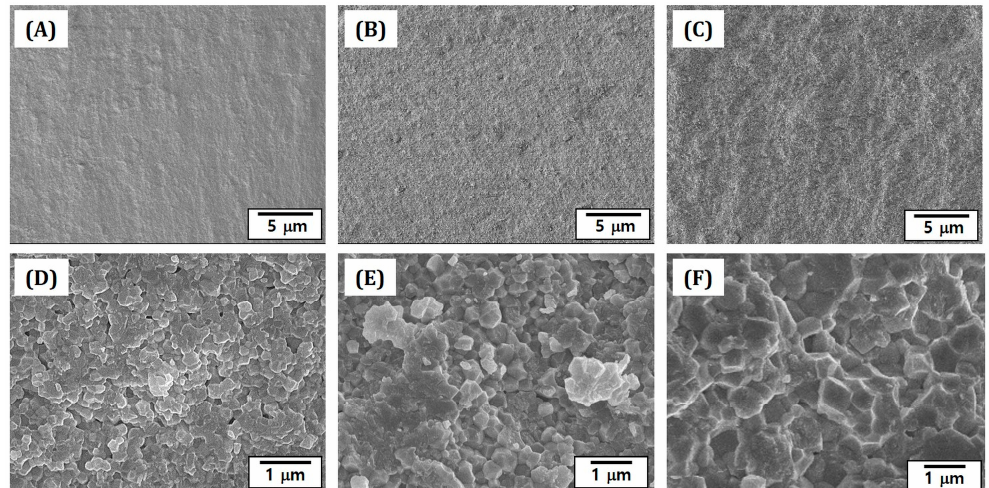
Figure 10. Representative FE-SEM images showing the fracture surfaces of 4Y-PSZ disks sintered for 3 h at various temperatures: 1300 °C ( A , D ), 1400 °C ( B , E ), and 1500 °C ( C , F ).